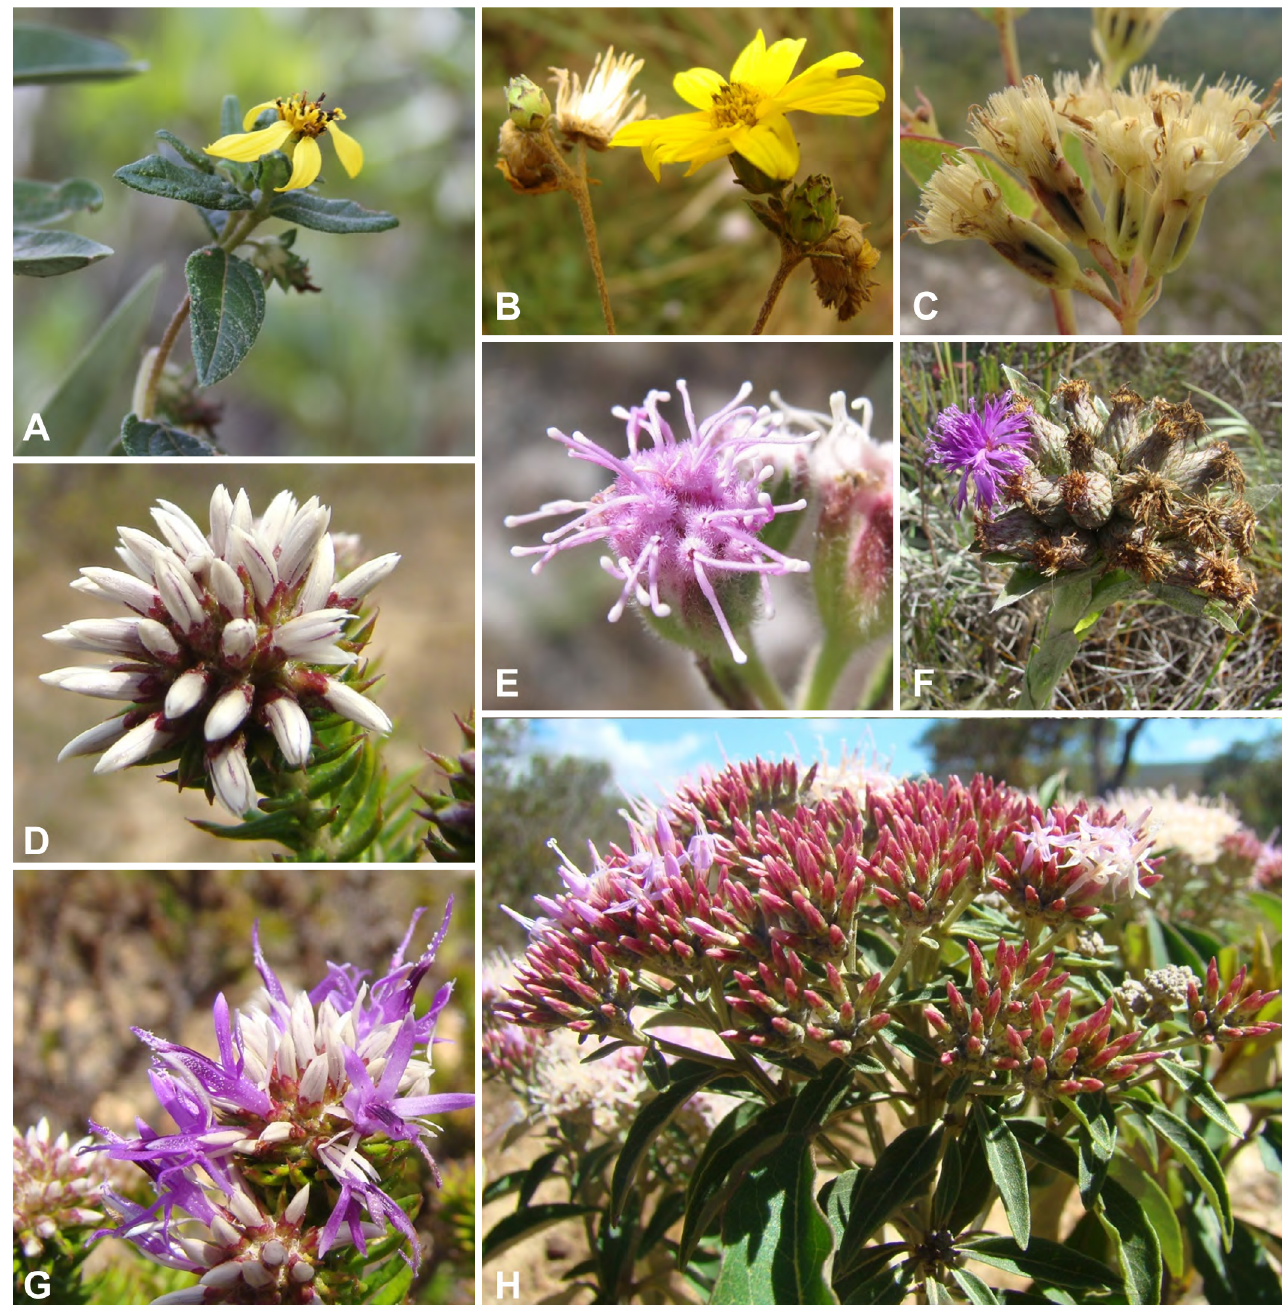
Figure 2. Images of the analyzed species. A: Aspilia eglerii J.U. Santos. B: Aspilia floribunda (Gardner) Baker. C: Mikania obtusata DC. D and G :